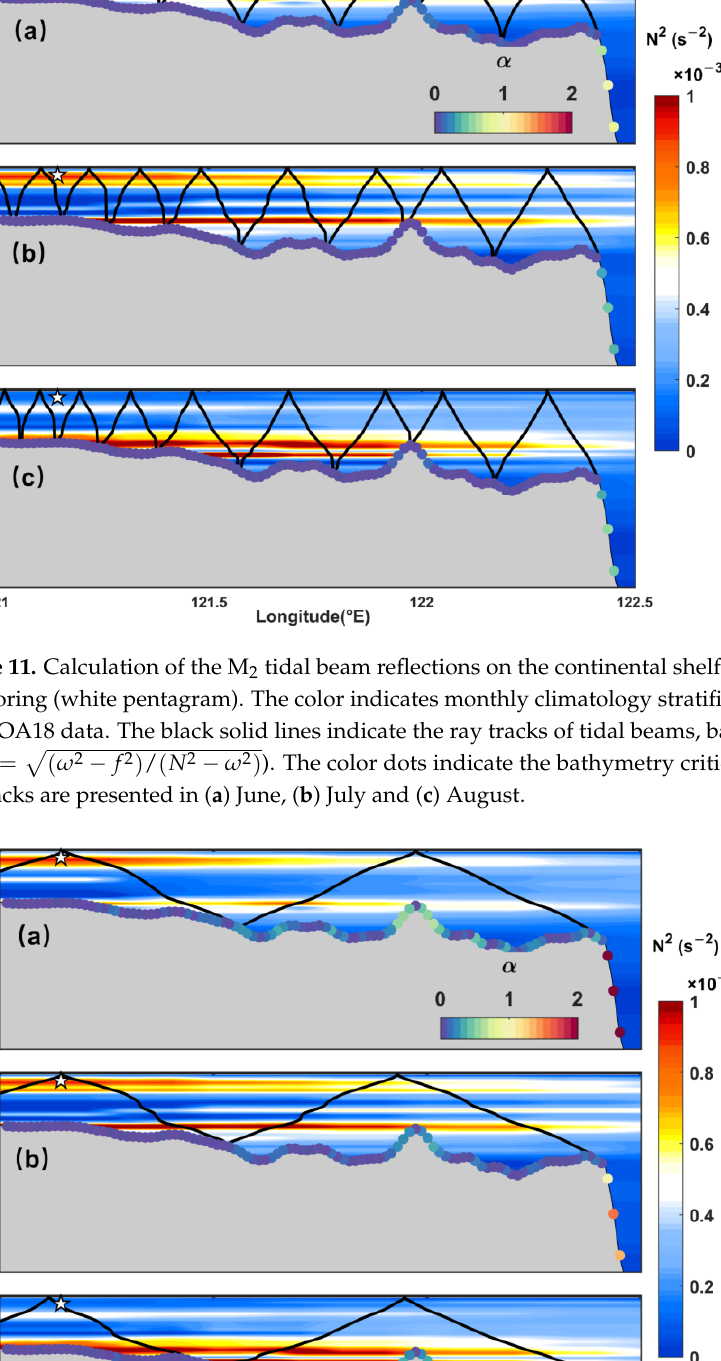
Figure 12. Same as in Figure 11, but for the K 1 tidal beam.